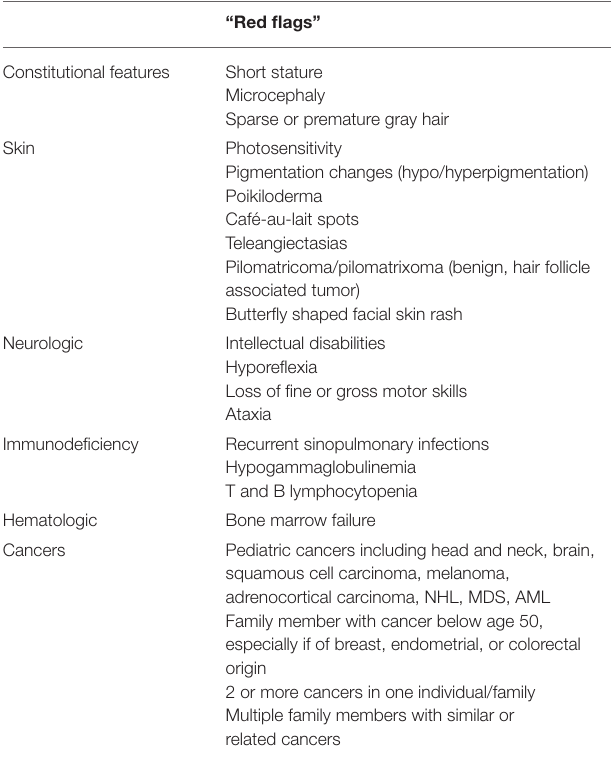
TABLE 2 | The presence of multiple red flags in the medical and/or family history increases concern for an underlying DNA repair disorder and should warrant further